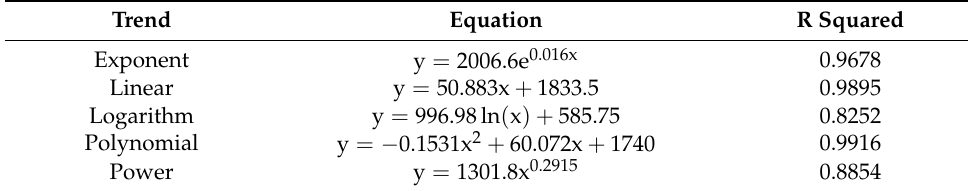
Table 4. Equations of variation trends for average yields of world rice from 1961 to 2019. Trend